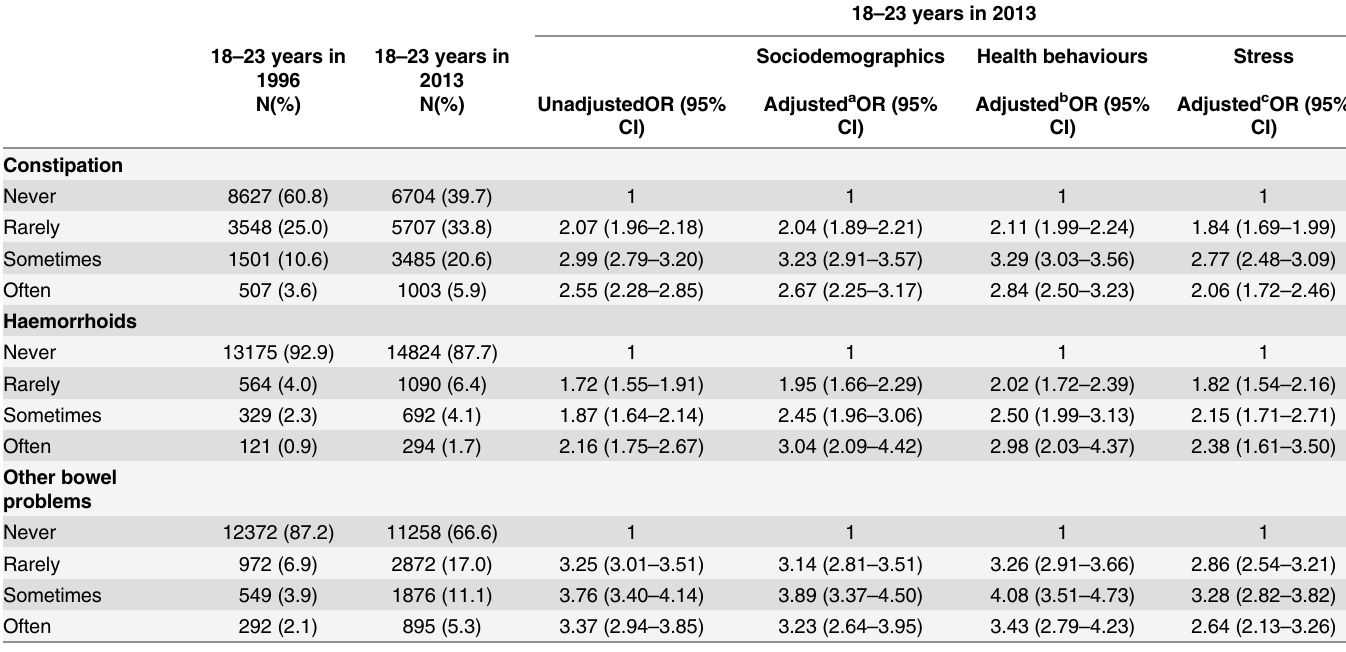
Table 4. Comparison of digestive and intestinal symptoms between two cohorts of young women aged 18 to 23 years in 1996 and in 2013. Odds ratios for participants in 2013 compared to participants in